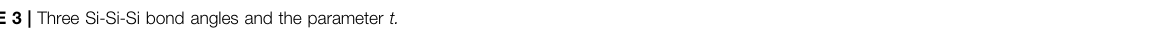
TABLE 3 | Three Si-Si-Si bond angles and the parameter